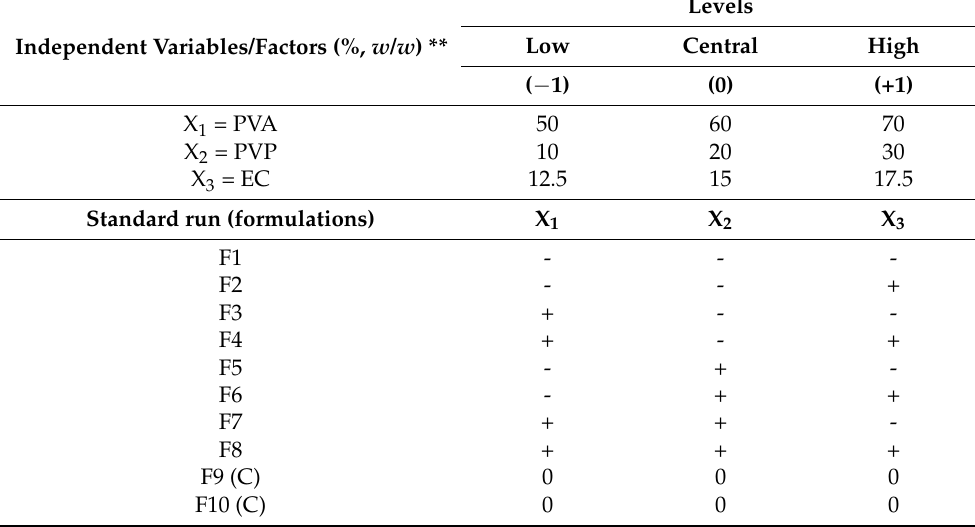
Table 1. Matrix of factorial design matrix 2 3 (plus two center points) for formulations containing polyvinyl alcohol (PVA), polyvinylpyrrolidone (PVP), ethylcellulose (EC) and tramadol (10%, w / w ) *.